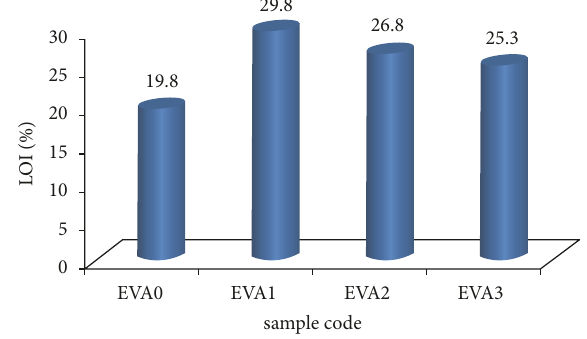
Figure 7: LOI values of EVA/LDHs